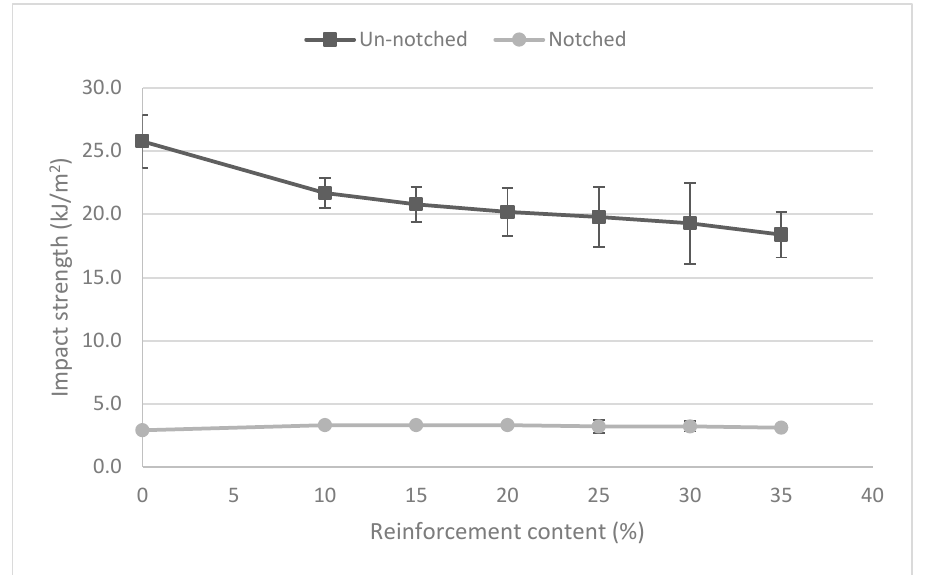
Figure 2. Evolution of the Charpy un-notched and notched impact strengths of the composites against BKSP content.